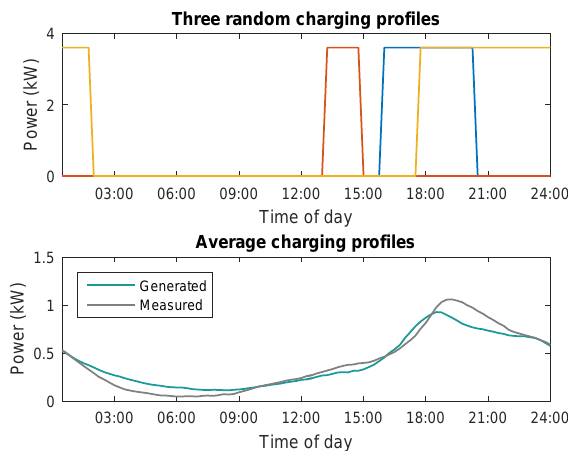
Figure 10. Individual and aggregated profiles for charging of electric vehicles at a charging rate of 3.6 kW.